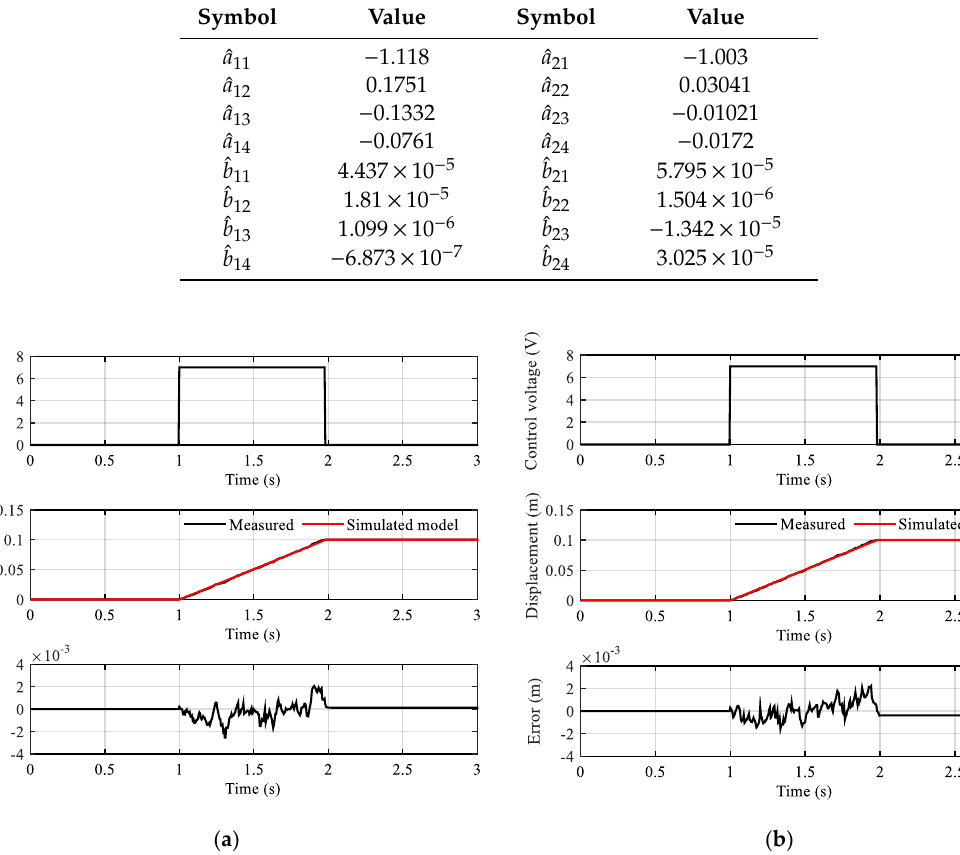
Figure 4. The fitting results: ( a ) Control input signal and fitting curves of the subsystem G 1 ; ( b ) Control input signal and fitting curves of the subsystem G 2